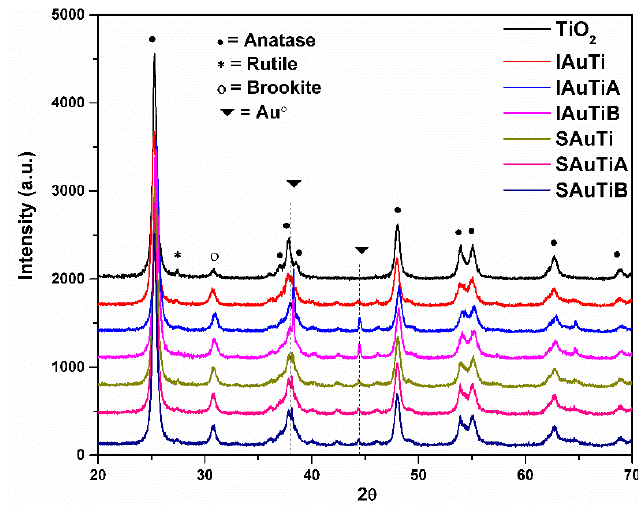
Figure 3. X ‐ ray diffraction of the samples synthesized by “Suspension Impregnation Method” (SiM) and “Incipient Impregnation Method”